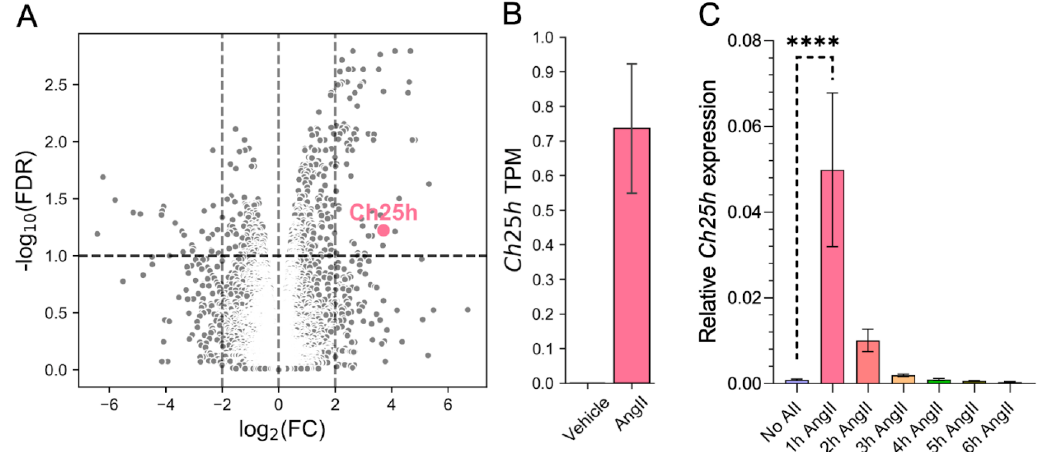
Figure 1. Ch25h gene expression is upregulated by AngII stimulus in rat VSMCs. ( A ) Serum-deprived VSMCs were stimulated with 100 nM AngII or treated with vehicle for 2 h. The results of the DE analysis of RNA-sequenced samples are shown as a volcano plot (x-axis: log 2 (FC, fold change) q, y-axis: − log 10 (FDR, false discovery rate) based on the Benjamini–Hochberg correction of p -values. Of the significantly upregulated genes, the Ch25h is marked in pink. The horizontal line represents the significance threshold (FDR < 0.1). ( B ) The mean transcript per million (TPM) values of the Ch25h in 2 h AngII-stimulated (TPM = 0.74) VMSCs were changed compared to vehicle-treated (TPM = 0) VMSCs. ( C ) Serum-deprived VSMCs were stimulated with 100 nM AngII for 1, 2, 3, 4, 5, and 6 h or not stimulated. Total mRNA was isolated from these cells. Following cDNA preparation, qRT-PCR was performed. Ch25h mRNA levels are presented relative to Gapdh . Values are plotted as the mean ± SEM of n = 5 independent experiments. Data were analyzed using multiple linear regression, **** p <